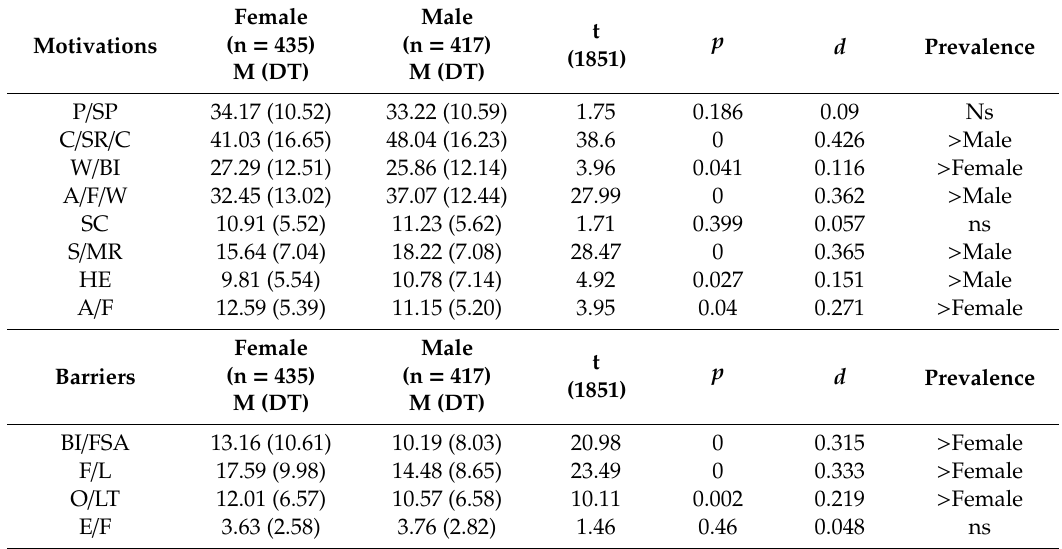
Table 4. Standard deviations, independent t test, e ff ect size ( d ) of the motivations, and barriers according to